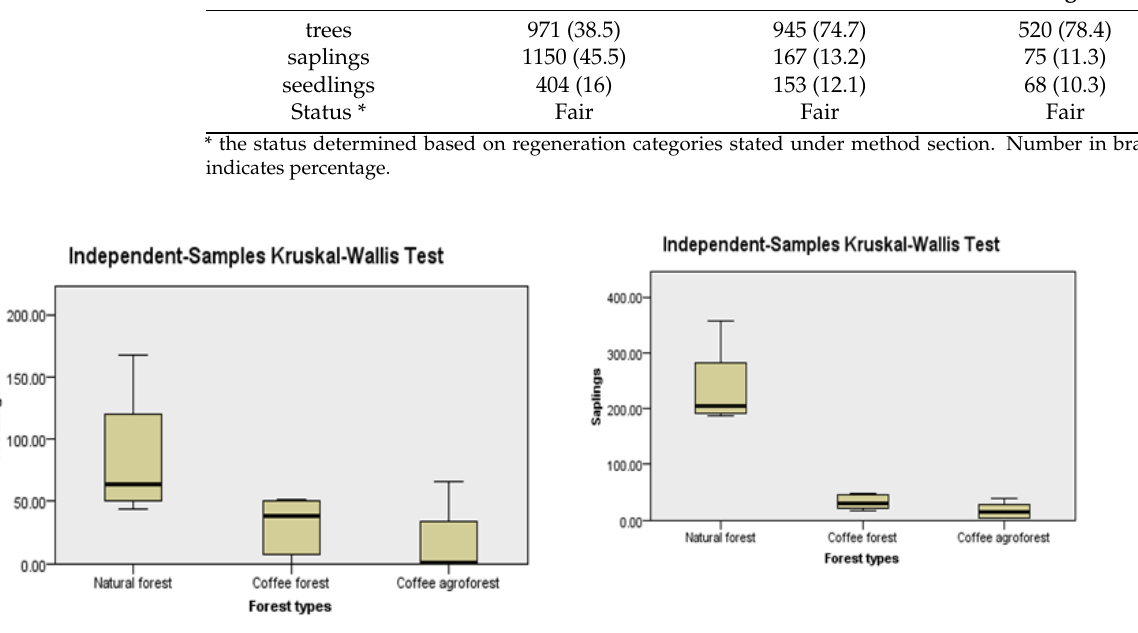
Figure 7. Comparisons of seedlings ( left ) and saplings ( right ) regeneration in the natural forest, coffee forest and coffee agroforest. coffee forest and coffee